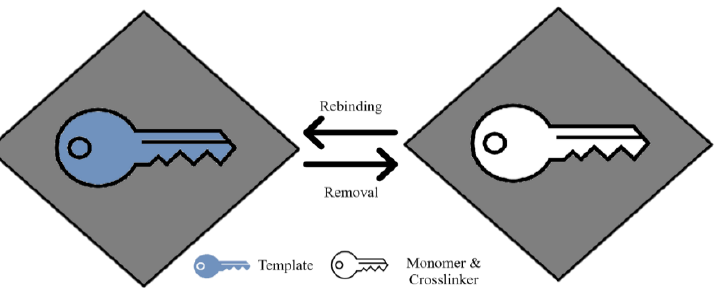
Figure 1. Concept of molecularly imprinted polymers and the adsorption capacity of nonimprinted polymers.